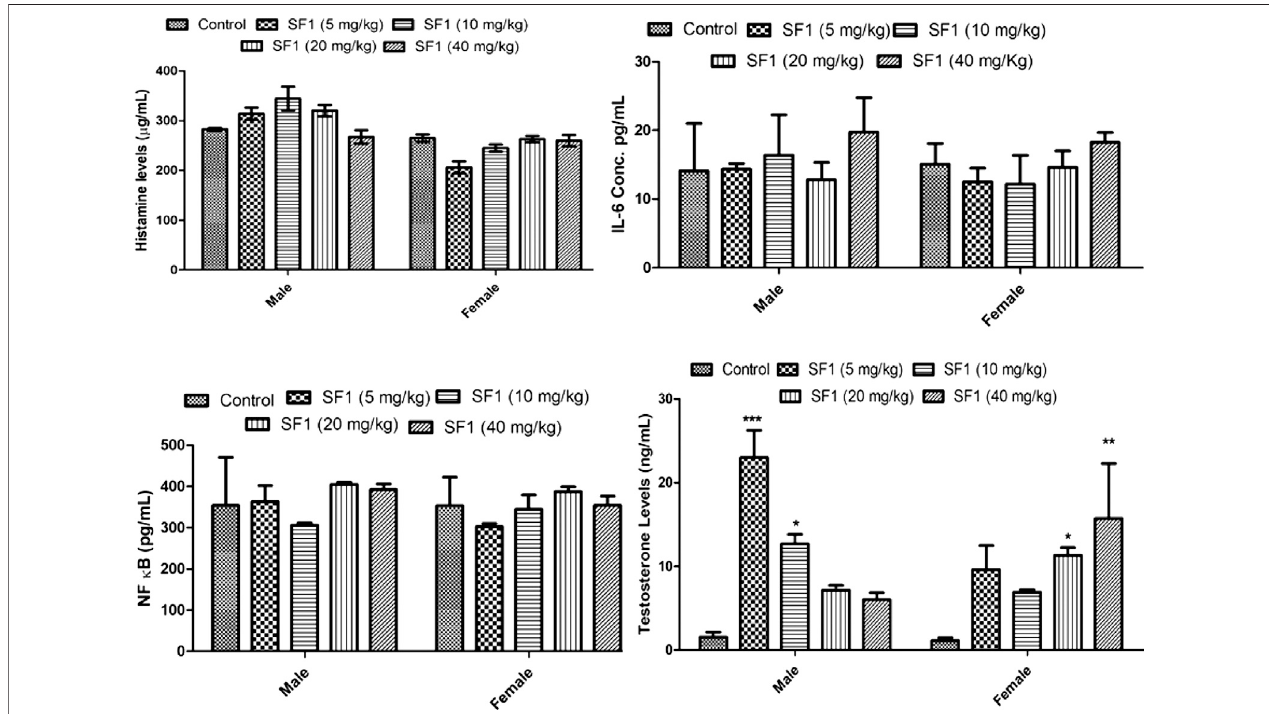
FIGURE 9 | Estimation of histamine, testosterone, IL-6 and NF- κ B levels in serum during subacute toxicity study. The data is represented as mean ± SEM ( n (cid:1) 3). * p < 0.05 is the signi fi cance level in comparison to the control.